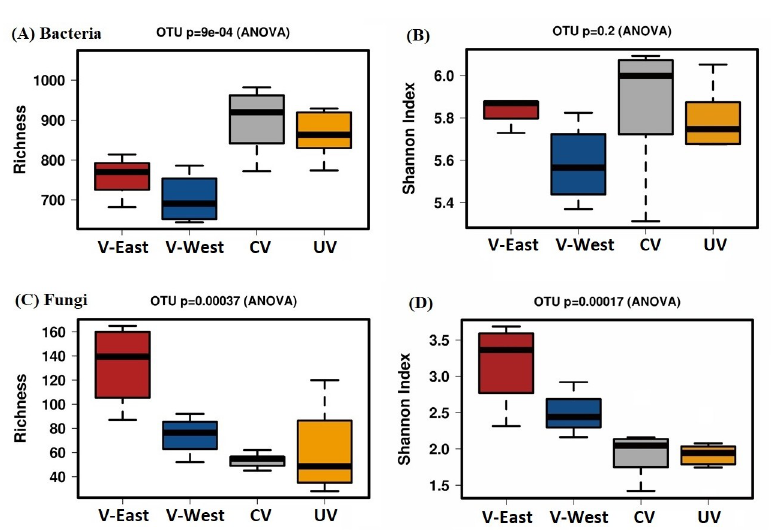
Fig 2. Richness and Shannon index represent alpha diversity of bacterial and fungal communities of the four sites. The number of OTUs were used as a measure of the richness and Shannon index for both prokaryotic ( A, B ) and fungal ( C, D ) communities in the peripheral vegetated, V-East and V-West sites and the central vegetated (CV) and the un-vegetated (UV) sites. Lower, mid, and upper horizontal lines represent the first quartile, median and the third quartile, respectively.